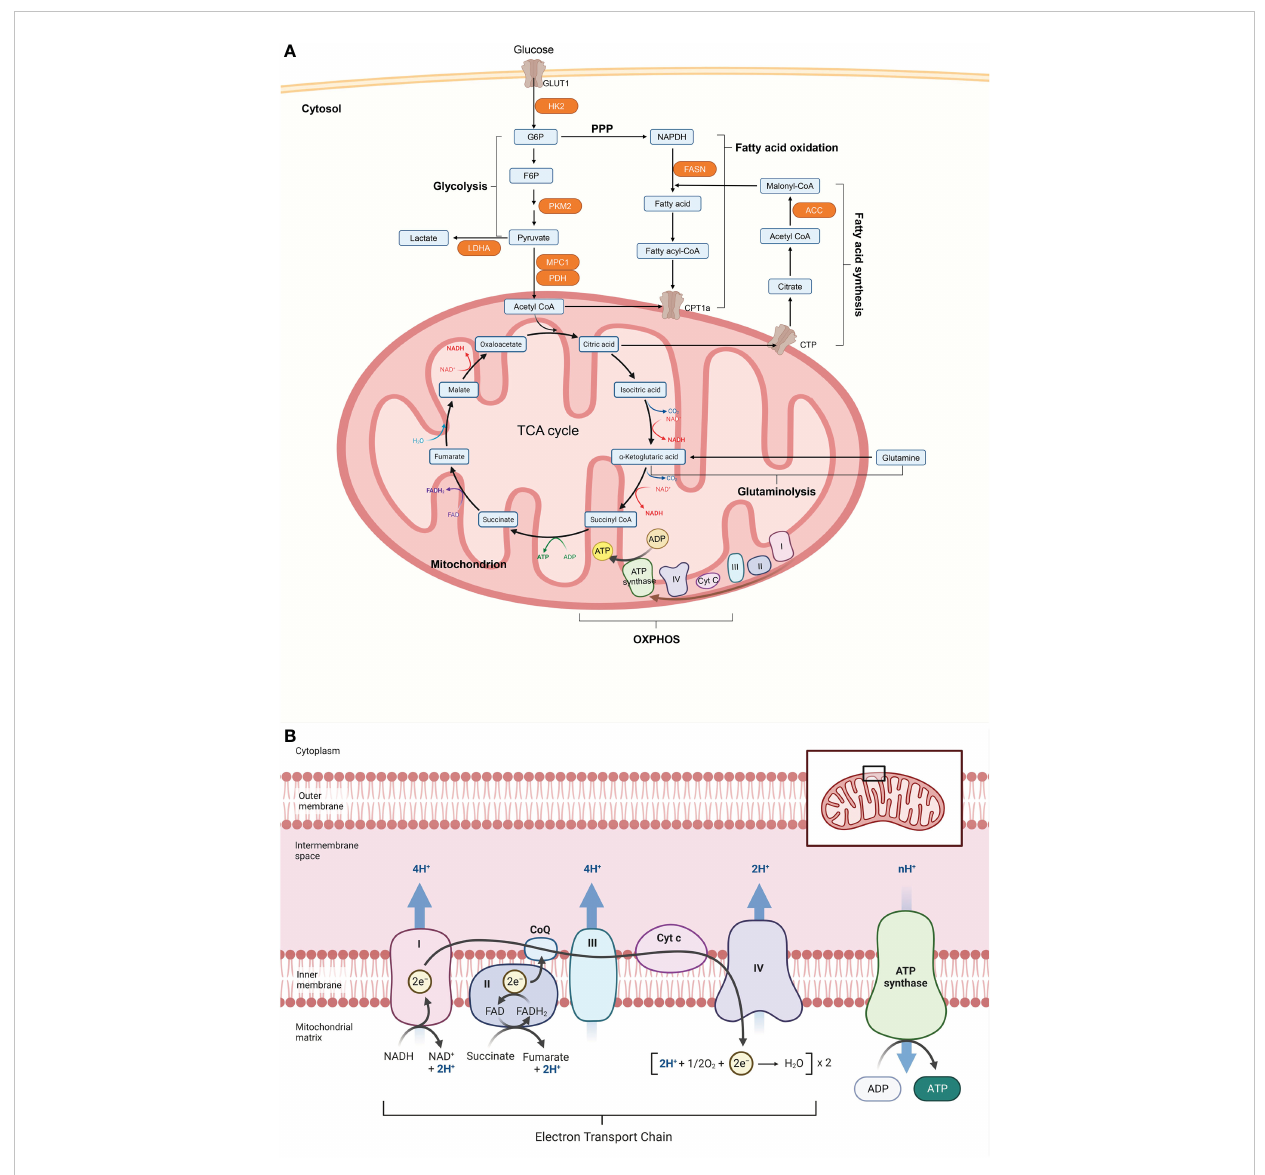
FIGURE 2 Cellular metabolism networks. (A) Glucose is imported from the extracellular environment and can either be converted to glycogen or oxidized during glycolysis to produce adenosine triphosphate (ATP). Pyruvate produced by glycolysis can be partially oxidized to lactate to quickly regenerate the consumed nicotinamide adenine dinucleotide (NADH), or it can be translocated into the mitochondria and completely oxidized via the tricarboxylic acid (TCA) cycle. The TCA cycle can also be powered by fatty acids through fatty acid oxidation or glutamine through glutaminolysis. Electrons released by glycolysis and the TCA cycle enter the electron transport chain, which is made up of complex I-V (CI-CV), where ATP is produced through oxidative phosphorylation (OXPHOS). (B) Acetyl-CoA from pyruvate enters the TCA cycle in mitochondria. Reactions in the cycle produce NADH and FADH, which act as substrates for the electron transport chain (ETC) and thus support OXPHOS and ATP production. Figure 2 was created with Biorender.com. ACC, acetyl-CoA carboxylase; CoA, coenzyme A; CPT1a, carnitine palmitoyltransferase 1; CTP, citrate transport protein; F6P, fructose 6 phosphate; FASN, fatty acid synthase; G6P, glucose 6 phosphate; GLUT1, glucose transporter 1; HK2, hexokinase 2; LDHA, lactate dehydrogenase A; MPC1, mitochondrial pyruvate carrier 1; NADPH, nicotinamide adenine dinucleotide phosphate; PDH,